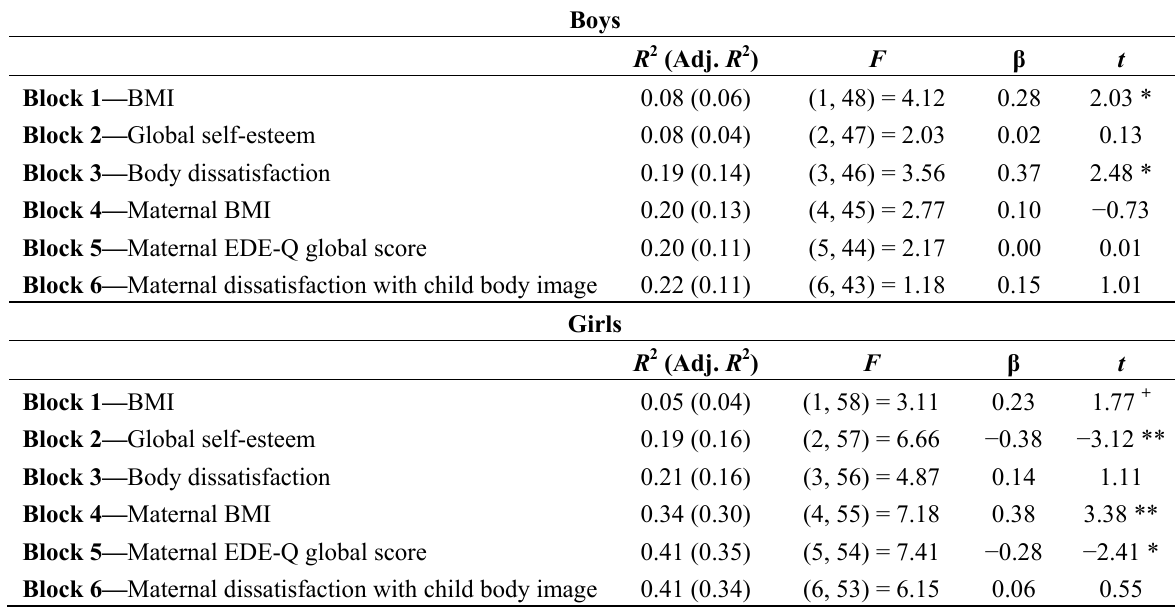
Table 3. Regression models that predict ChEAT global scores for boys and girls.